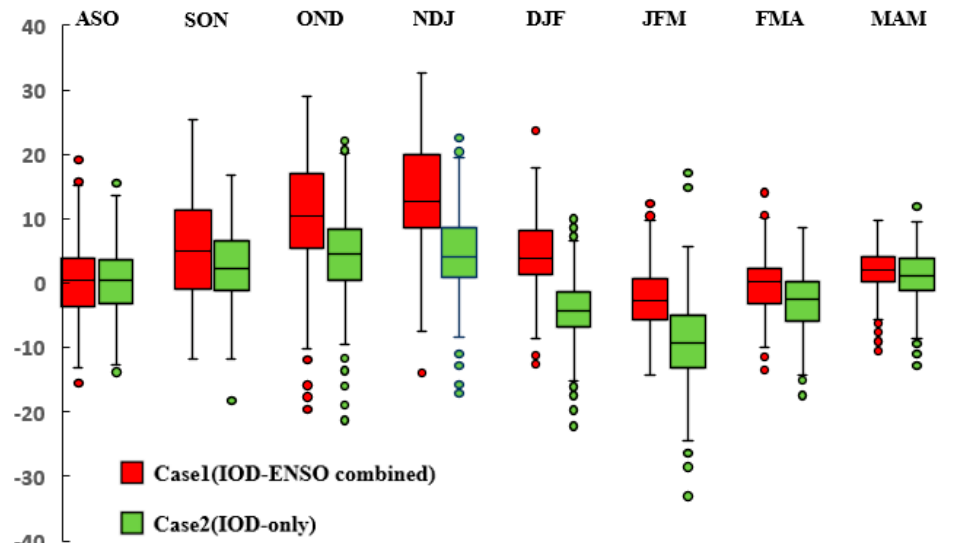
Figure 5. Boxplots of percentage changes in the intentionally biased bootstrapping simulation of running three-month precipitation from ASO to MAM (refer to Section 2.2 for definitions) over southern China (SC) in the case of Case 1 (IOD-El Niño–Southern Oscillation (ENSO) combined) and Case 2 (IOD-only) with DMI + 1 SD.